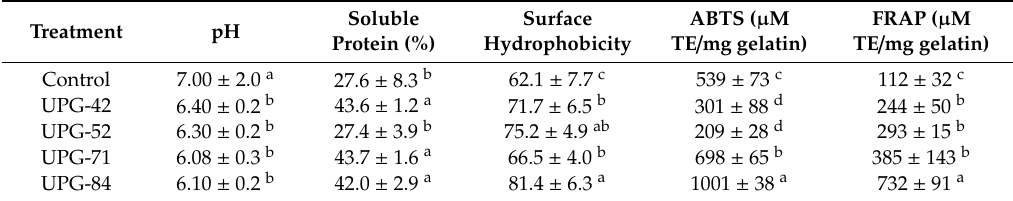
Table 1. Antioxidant activity, pH, protein solubility, and surface hydrophobicity of tilapia ( Oreochromis niloticus ) skin gelatins that were treated with high-intensity ultrasound